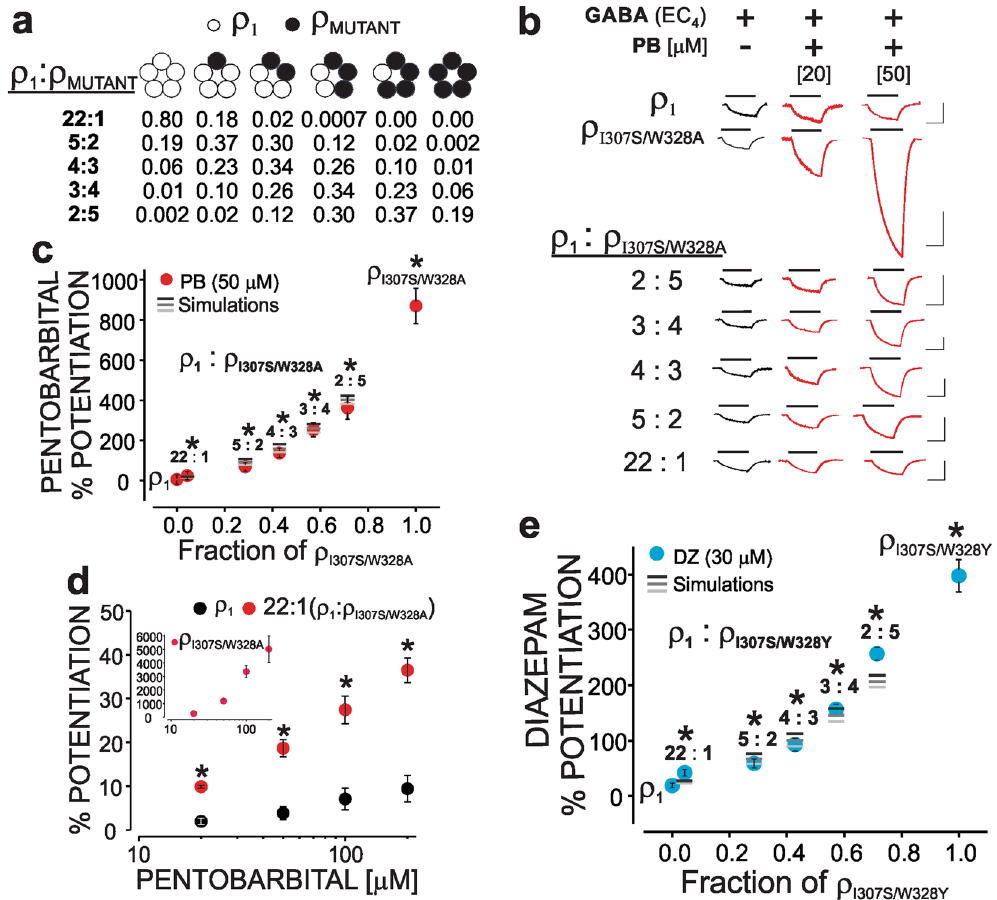
Figure 5. Hetero-oligomeric ρ 1 receptors containing a single mutated subunit confer anaesthetic potentiation. ( a ) The predicted quantities of the receptor sub-populations expected from the co-expression of different ratios of wild-type to mutant cRNA. ( b ) Current traces elicited by EC 4 GABA and EC 4 GABA plus 20 or 50 µ M PB for ρ ρ ρ ρ 1 , I307S/W328A , and different ratios of 1 : I307S/W328A . The lines above the current traces represent the duration of the drug application. The vertical and horizontal bar scales denote 50 nA and 100 seconds, respectively. ( c ) PB- dependent potentiation of EC 4 GABA for ρ 1 , ρ I307S/W328A , and different ratios of ρ 1 : ρ I307S/W328A . ( d ) Potentiation of the EC 4 GABA by 20, 50, 100, and 200 µ M PB for ρ 1 , and 22:1 ratio of ρ 1 : ρ I307S/W328A as well as ρ I307S/W328A (inset). ( e ) Potentiation of the EC 4 GABA by 30 µ M DZ for ρ 1 , and different ratios of ρ 1 : ρ I307S/W328Y . The three shades of grey horizontal lines in c and e are simulated models for the potentiation experiments. The differences in the potentiation levels between the different ratios of the ρ 1 :mutant and ρ 1 are statistically significant (p <